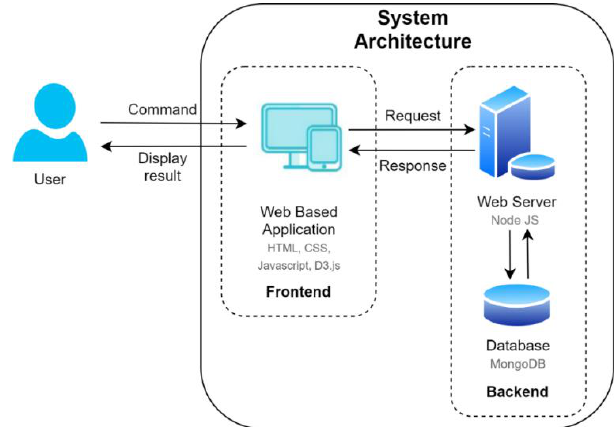
Figure 3. System architecture.